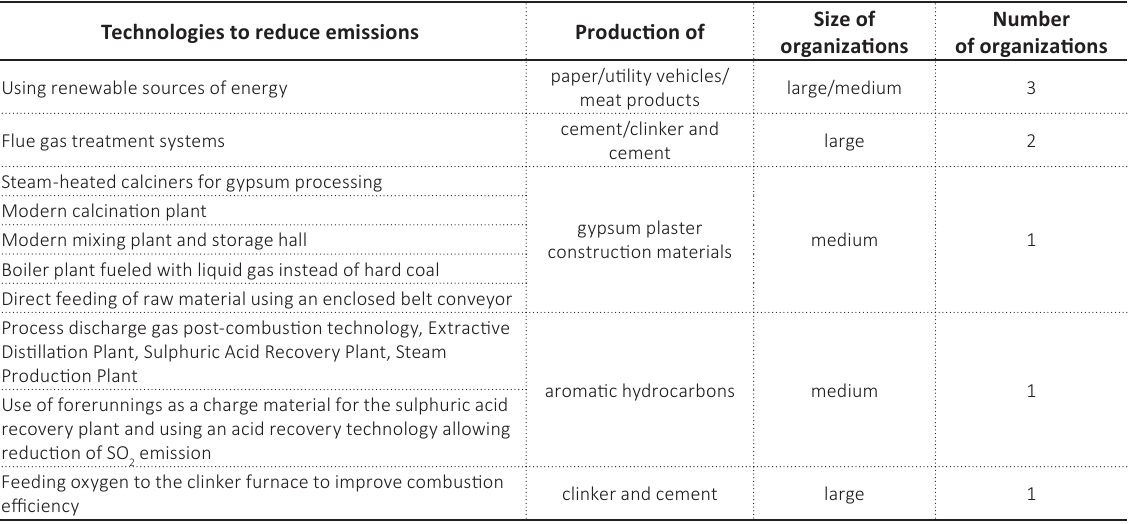
Table 2. Technologies used by Polish companies registered with EMAS to reduce the emission of air